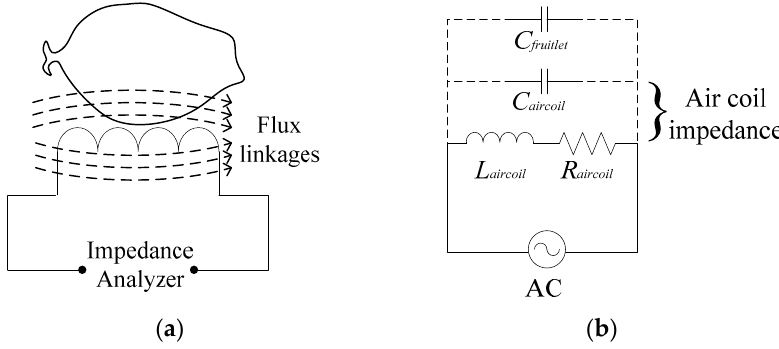
Figure 1. ( a ) Single flat-type shape air coil electrical diagram; ( b ) Series RLC circuit representation.